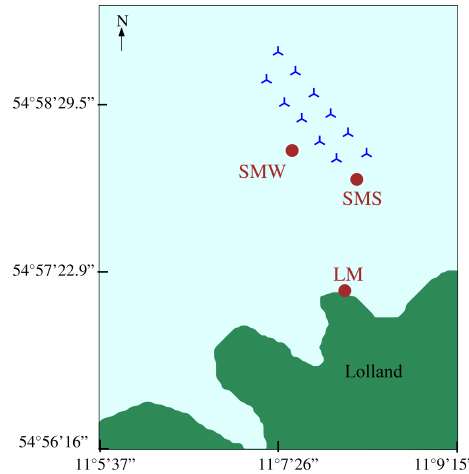
Figure 2. Vindeby Offshore Wind Farm layout with circles marking the position of the masts: SMW, SMS, and LM. SMW is located approximately 1.5km from